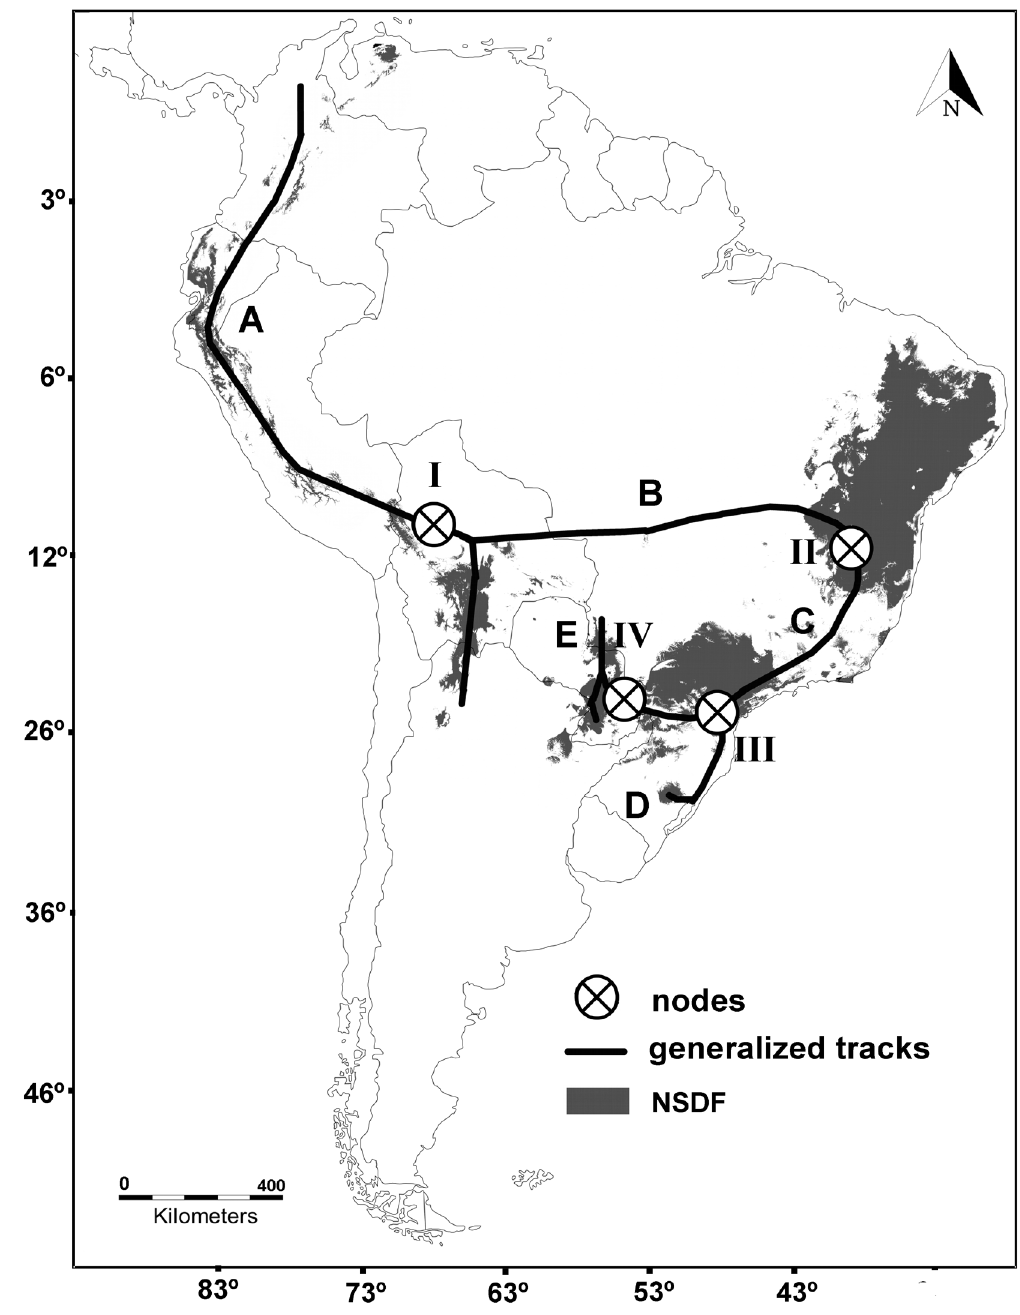
Figure 2 – Generalized tracks: A, Andean; B, Brazilian; C, Parana; D, Pampean; E, Chacoan; Nodes I, II, III and IV and Neotropical seasonally dry forests (NSDF; sensu Särkinen et al .